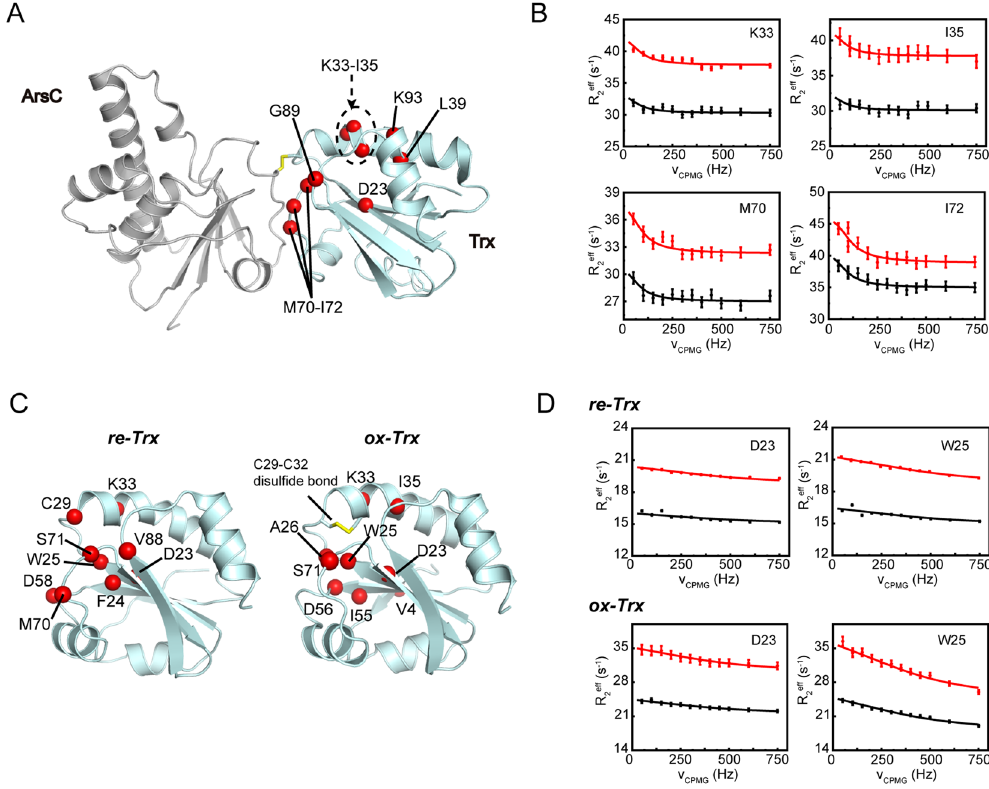
Figure 6. CPMG RD results of Trx in the complex and free states. ( A , C ) Residues showing conformational exchanges in c-Trx ( A ) or re-Trx , ox-Trx (B) identified by the CPMG RD experiments are mapped onto the structures (shown as red spheres). ( B ) Representative RD profiles of c-Trx (B), re-Trx and ox-Trx ( D ) obtained on 600-MHz (black) and 800-MHz (red)